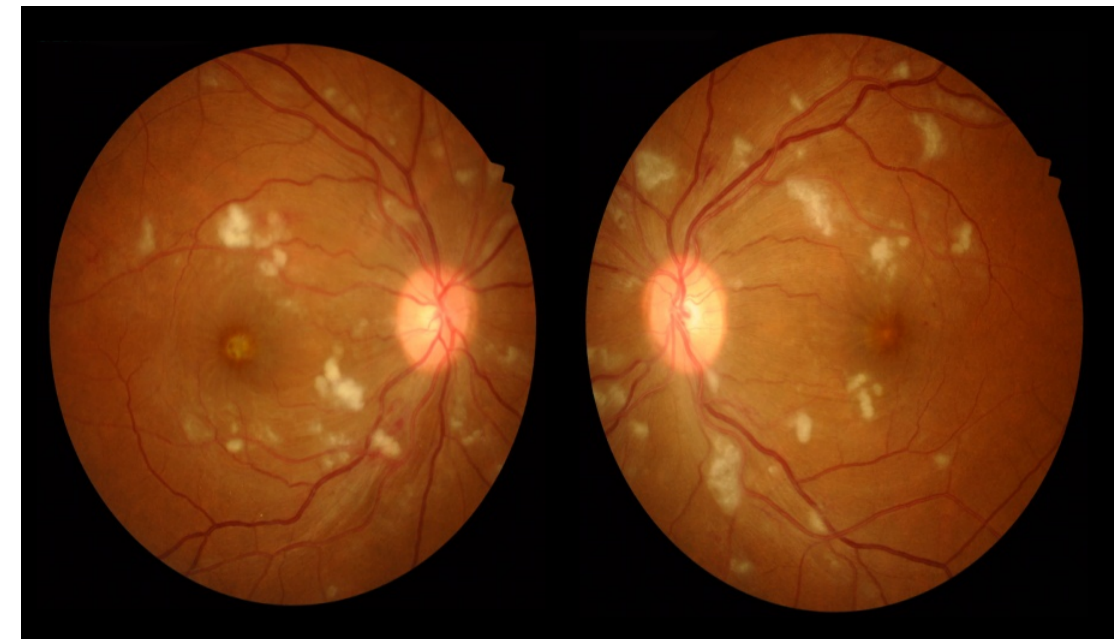
Figure 1: Fundus pictures: bilateral multiple cotton wool exudates, dot hemorrhage known as Purtscher’s flecken, macula star pattern cup to disc ratio 0.31